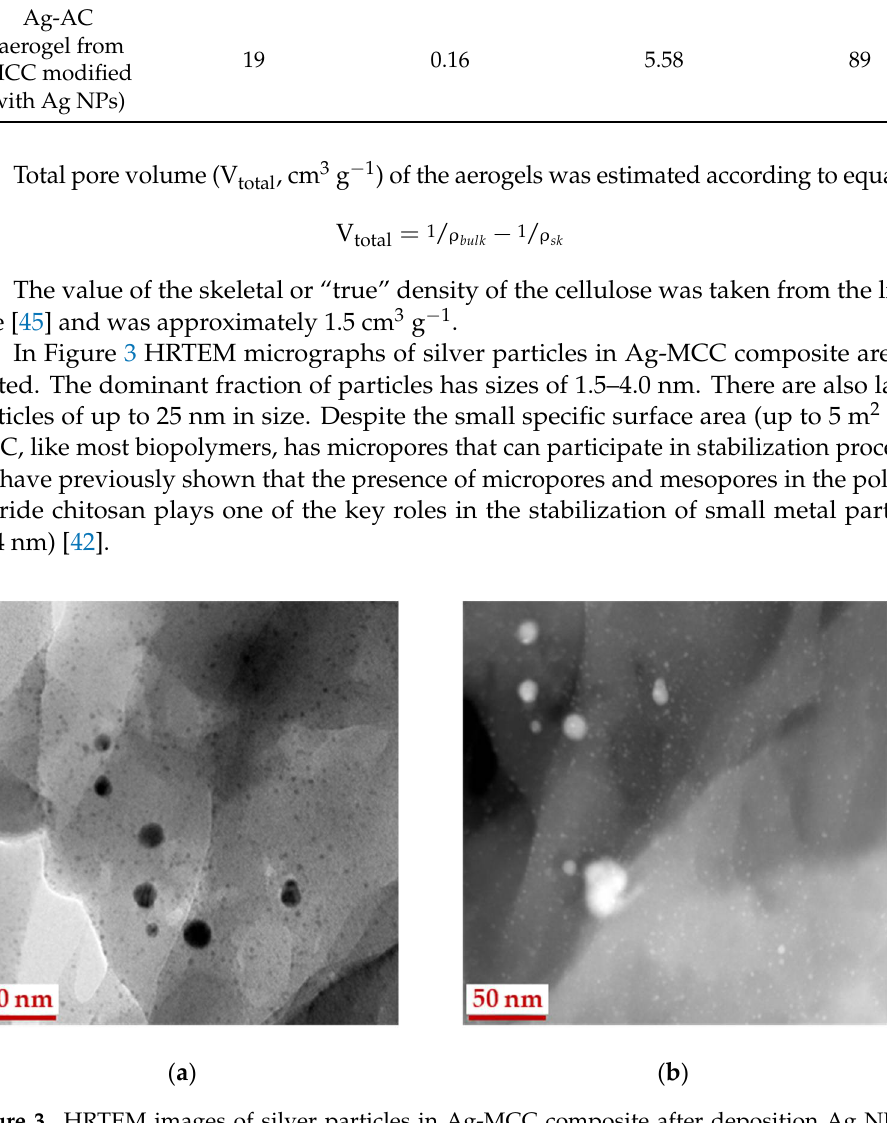
Figure 3. HRTEM images of silver particles in Ag-MCC composite after deposition Ag NPs on microcrystalline cellulose, in bright ( a ) and dark ( b ) fields. microcrystalline cellulose, in bright ( a ) and dark ( b )